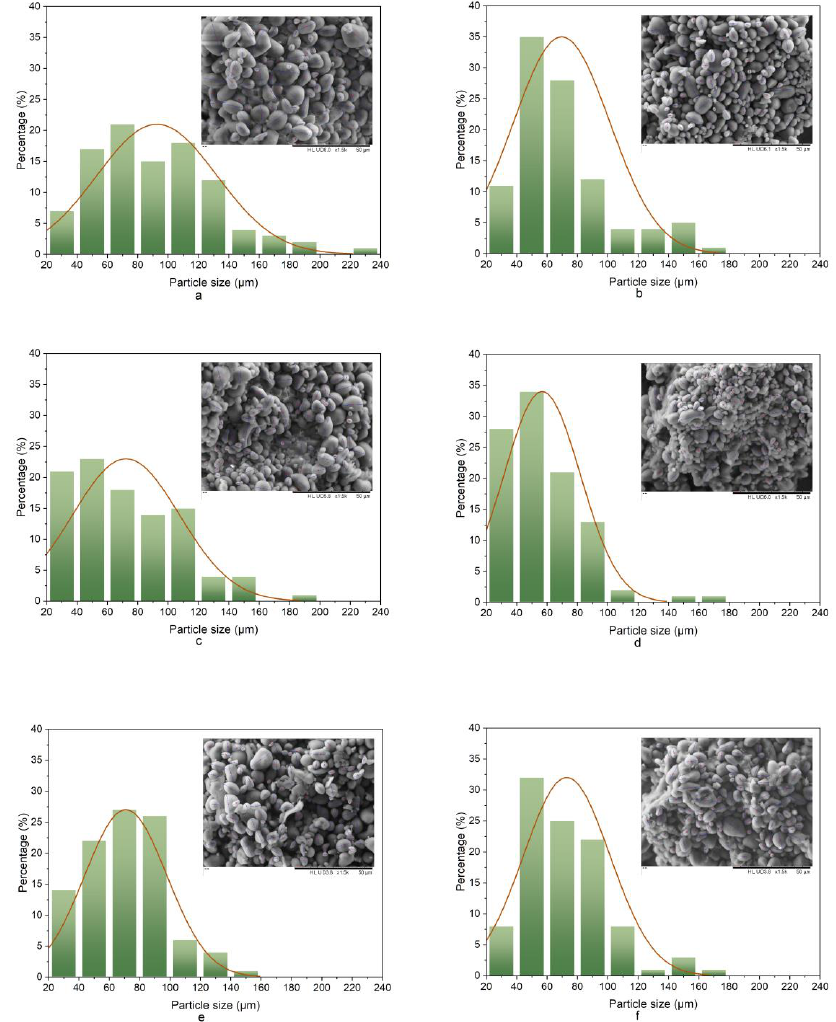
Figure 3. SEM image and particle size analysis of solid particles (1500×). ( a ): not homogenized; ( b ): 4000 rpm, 10 min; ( c ): 8000 rpm, 10 min; ( d ): 12,000 rpm, 10 min; ( e ): 16,000 rpm, 10 min; ( f ): 20,000 rpm, 10 min.